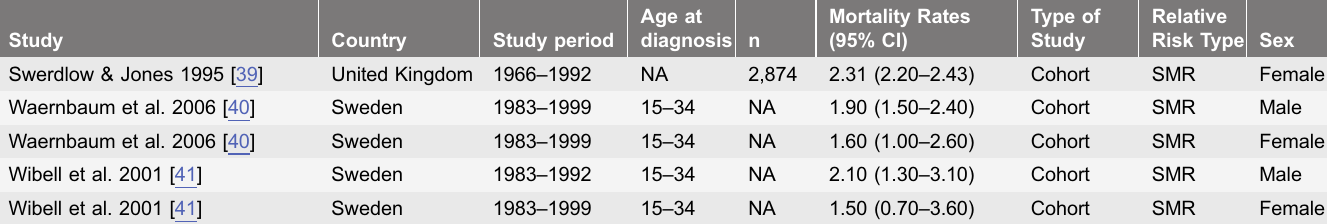
Results of the overall meta-analysis of 88 observations are shown in Table 2, and a meta-analysis forest plot is depicted in Figure 2, stratified by a studies commencement date. Overall RR of mortality was estimated at 3.82 (95% CI 3.41, 4.29) for Type 1 diabetes mellitus patients compared to the general population. The I-squared value was estimated at 96.0%, indicating the high degree of heterogeneity across studies.